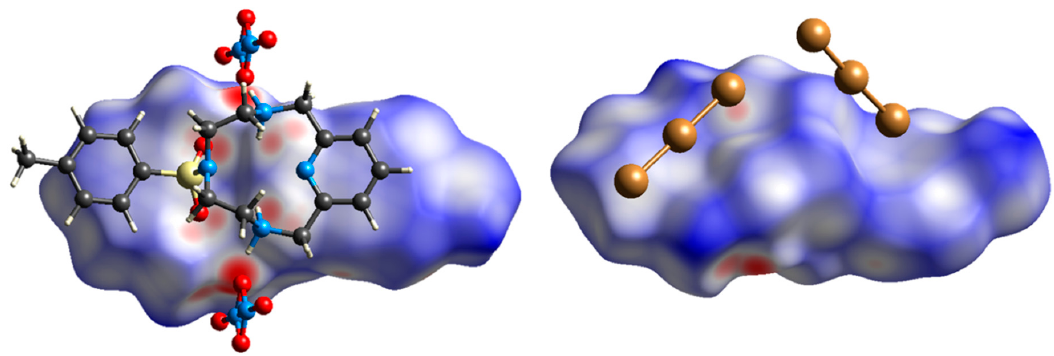
Figure 7. Depiction of (H 2 L-Ts) 2+ Hirshfeld surface under a d norm lens.